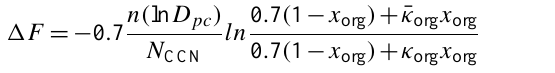
Fig. 4. Critical supersaturation (“ S crit ”, %) versus dry diameter as a function of κ value. Each solid black line highlights the rela- tionship between S crit and diameter for 4 reference κ values. The κ values derived from simulations assuming no re-equilibration of all semi-volatiles on drying are highlighted as solid green and red lines (green: 2 compound simulations, red: 10000 compound sim- ulations). The horizontal arrows span the range of κ values. The κ values derived from simulations assuming re-equilibration of all semi-volatiles on drying are displayed as dotted green and red lines. 3 example compounds are shown as blue lines, described in the leg- end.